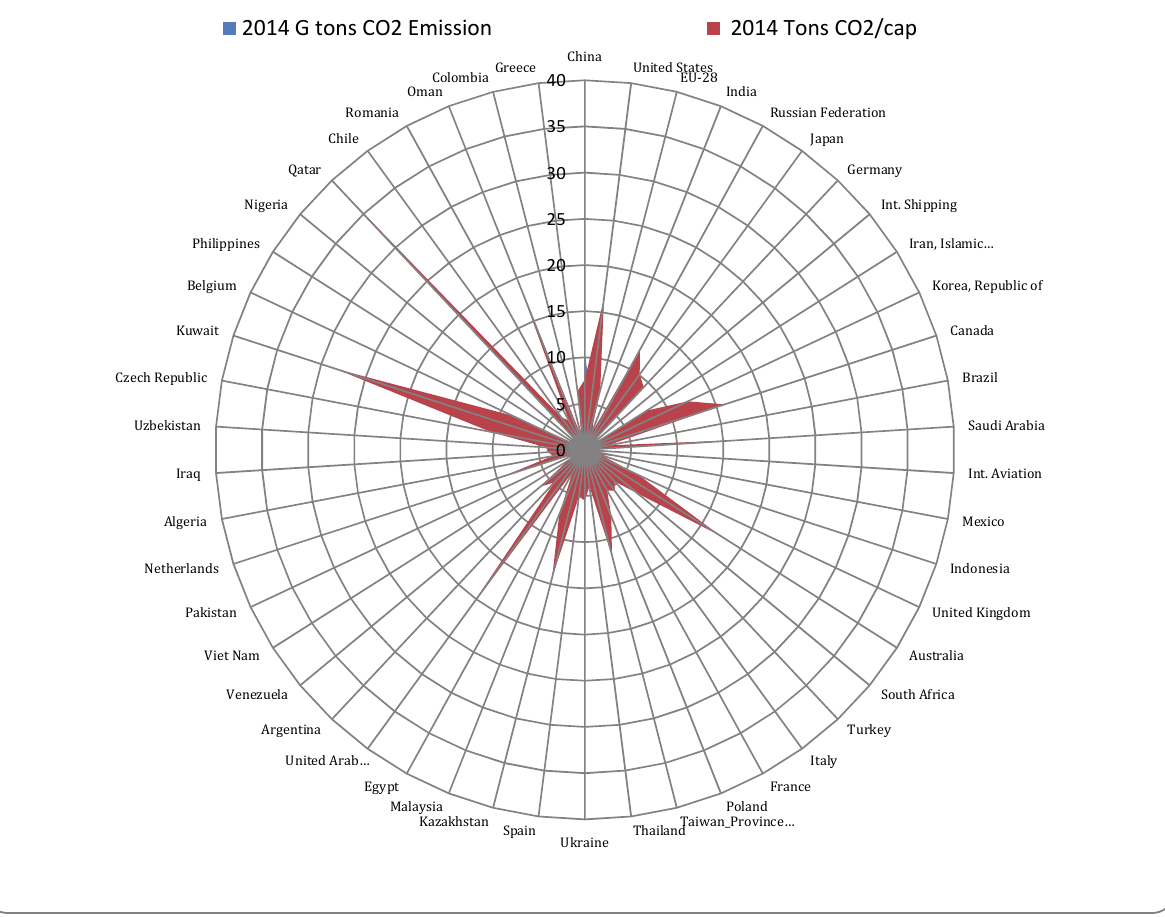
Fig. 1. Carbon dioxide emissions for the top 50 countries by total emissions in 2014given as totals and per